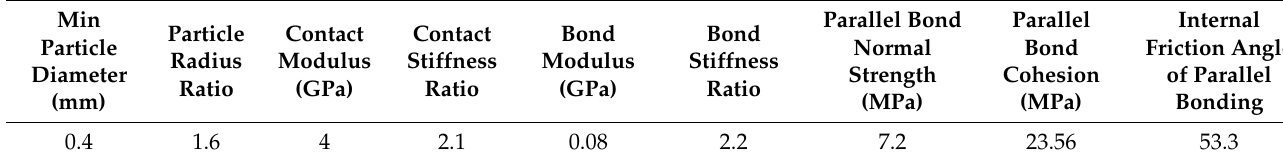
Table 1. Micro-mechanical parameters of the structural plane pattern.